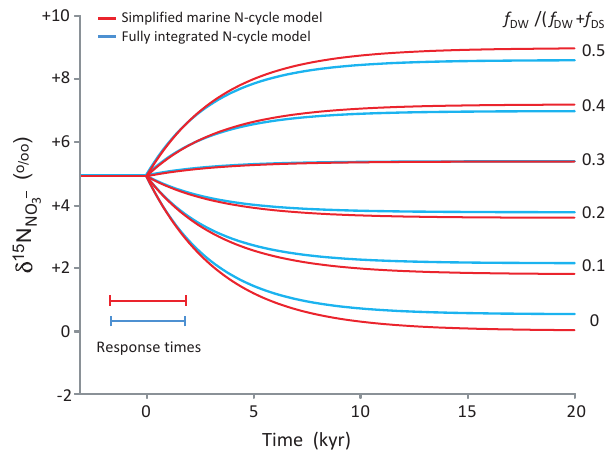
Fig. C2. Comparison of output of fully integrated and simplified N cycle models. At t ≤ 0, the model is at equilibrium and represents our “baseline” scenario ( f FIX = 220Tga − 1 , f DW = 60Tga − 1 , f DS = 160Tga − 1 , ε FIX = − 2‰, ε DS = − 2‰, ε DW = − 20‰, ε P = 0‰, and F DW = 0 . 27), which yields a seawater δ 15 N NO − 3 value of + 4.9‰ (i.e., equivalent to modern seawater nitrate; Sig- man et al., 2000). At t = 0, changes in F DW to values ranging from 0 to 0.5 result in evolution of δ 15 N ata rate reflecting the re- NO − 3 sponse time of the system (which is closely related to the ∼ 3kyr residence time of nitrate in seawater; Tyrrell, 1999). Differences in δ 15 N between the fully integrated model (blue curves) and sim- NO − 3 plified model (red curves) are generally < 0.4‰, indicating that the output of the simplified model is